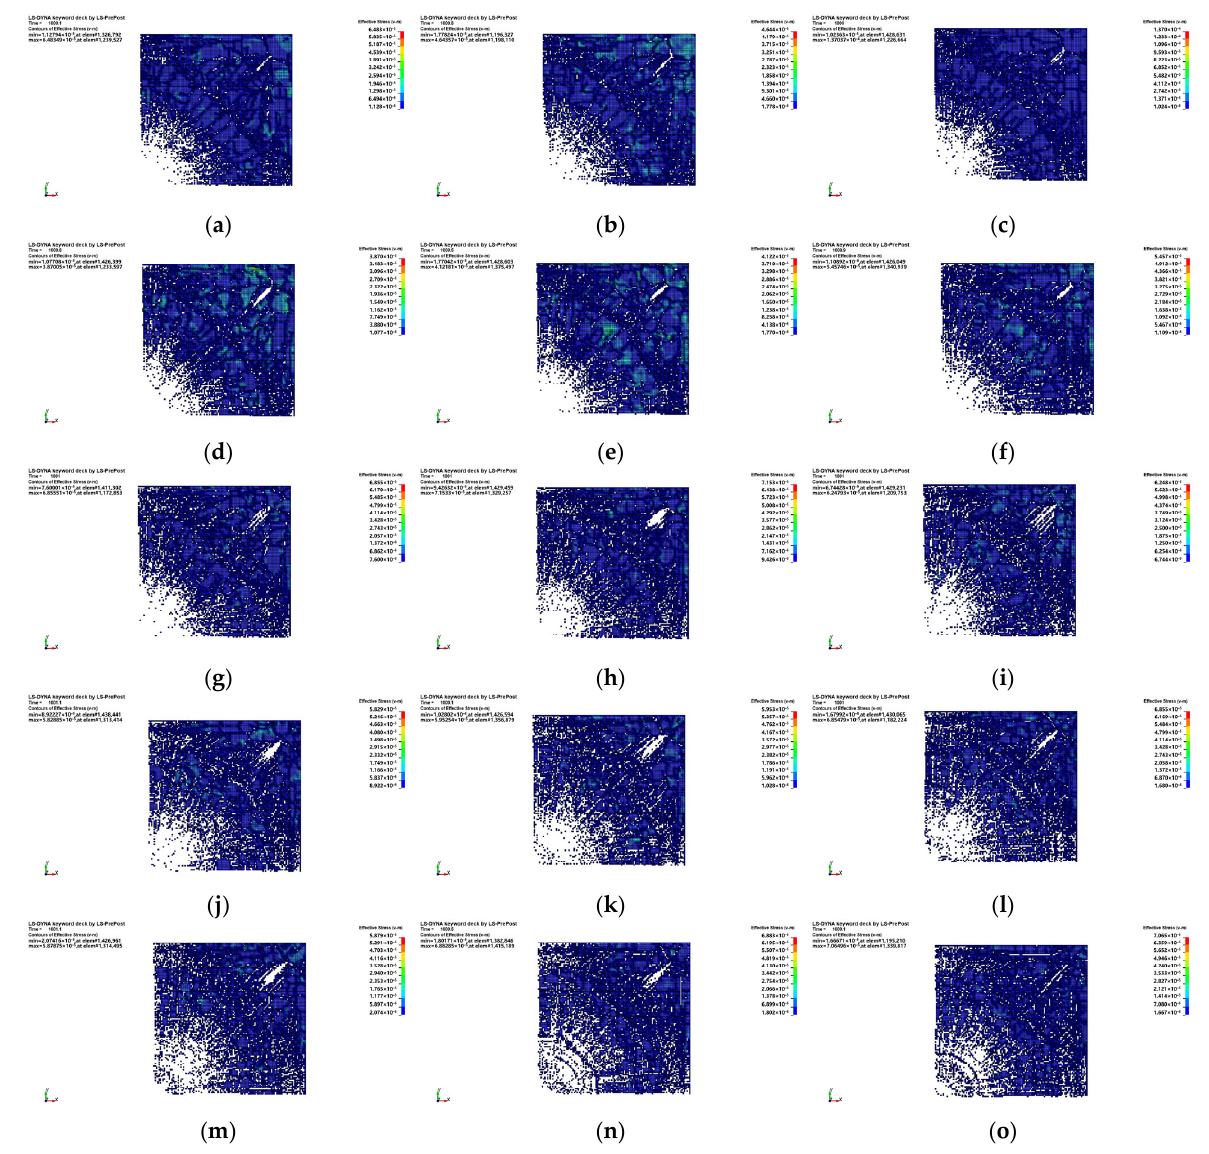
Figure 9. ( a ) the upper end of the explosive is 30 cm from the ice layer; ( b ) the upper end of the explosive is 40 cm from the ice layer; ( c ) the upper end of the explosive is 50 cm from the ice layer; ( d ) the upper end of the explosive is 60 cm from the ice layer; ( e )the upper end of the explosive is 70 cm from the ice layer; ( f ) the upper end of the explosive is 80 cm from the ice layer; ( g ) the upper end of the explosive is 90 cm from the ice layer; ( h ) the upper end of the explosive is 100 cm from the ice layer; ( i ) the upper end of the explosive is 110 cm from the ice layer; ( j ) the upper end of the explosive is 120 cm from the ice layer; ( k ) the upper end of the explosive is 130 cm from the ice layer; ( l ) the upper end of the explosive is 140 cm from the ice layer; ( m ) the upper end of the explosive is 150 cm from the ice layer; ( n ) the upper end of the explosive is 160 cm from the ice layer; ( o ) the upper end of the explosive is 170 cm from the ice